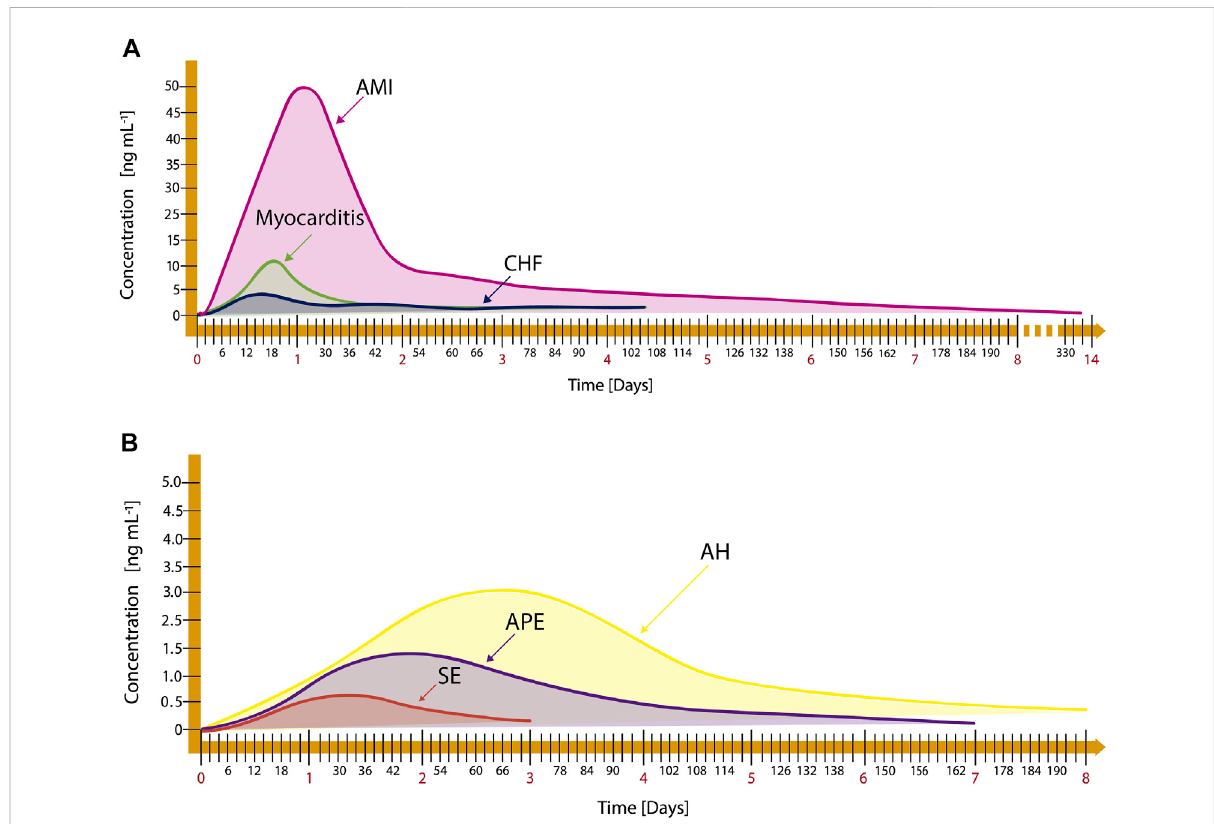
FIGURE 2 Release kinetics ofcardiac and non-cardiac diseases: (A) AMI, myocarditis, and Chronic Heart Failure (CHF), adapted fromMahajan and Jarolim (2011); Abdolrahim et al. (2015), and (B) Arterial Hypertension (AH), Acute Pulmonary Embolism (APE), and Strenuous Exercise (SE), adapted from Douketis et al. (2002); Taddei et al. (2011); Brzezinski et al.